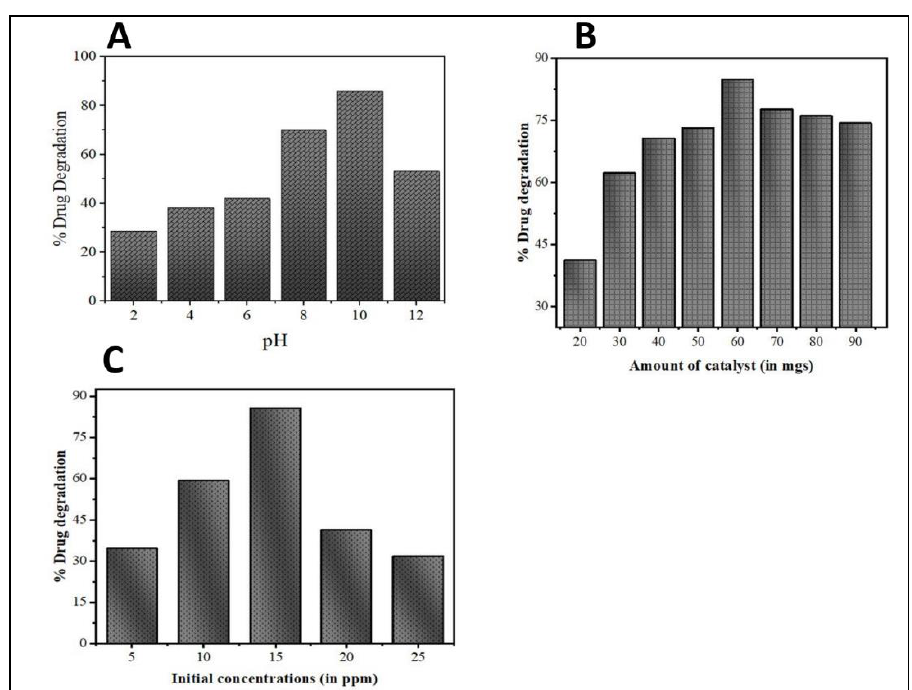
Figure 9. Different parameters were applied to degrade the antibiotic norfloxacin using Mn:ZnS Quantum Dots. ( A ) showing the effect of pH on norfloxacin, with pH = 10 owining the best photocatalytic efficiency( B ) represents a bar chart with the effect of the number of catalysts used. ( C ) signifies the effect of the initial antibiotic concentration. Adapted from [100].